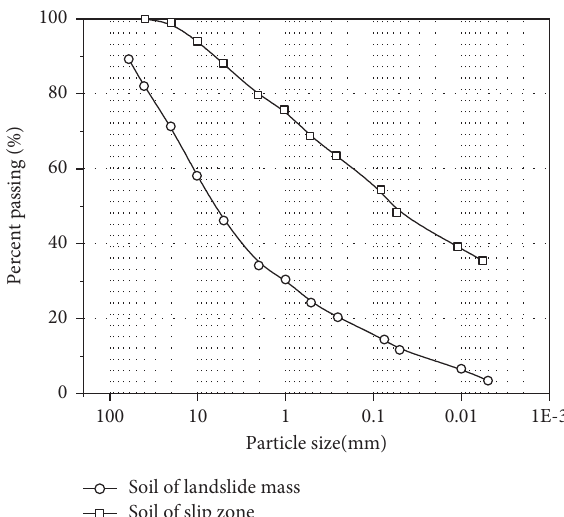
Figure 6: Particle size distribution for soil samples collected at landslide mass and slip